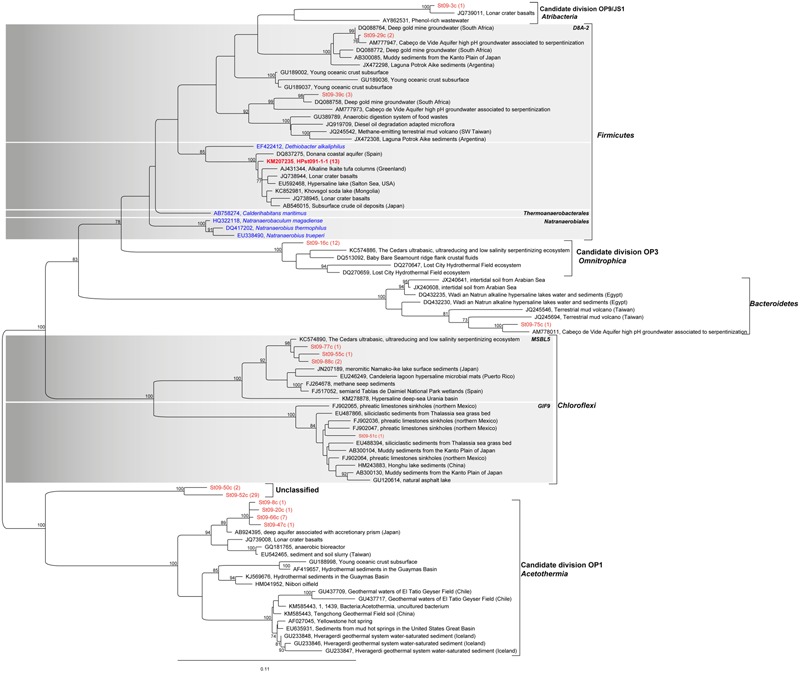
Phylogenetic tree of 16S rRNA gene sequences of Firmicutes, Acetothermia, Omnitrophica, Atribacteria, Bacteroidetes, and Chloroflexi (all in red) retrieved in the conduits of the nascent chimney sampled at site ST09 (bulk analysis). It shows in particular the position of the OTU KM207235 HPst091-1-1 also retrieved from conduit samples observed using CLSM (Table 1) and dominating within the Firmicutes phylum (Figure 6). The closest relatives are for all sequences, uncultured specimens hence, making difficult any assumptions on the involved metabolisms. Note that some sequences were only retrieved at PHB (e.g., St09-84c, St09-52c, St09-50c). The tree was constructed by maximum likelihood analysis, using 1,210 positions, including the closest possible uncultivated (black) and cultivated (blue) relatives as well as more distant representatives of cultivated species. Bootstrap values for nodes (>70% support) based on 1,000 replicates are displayed as percentages. The number of retrieved sequences is indicated in brackets after each clone name.